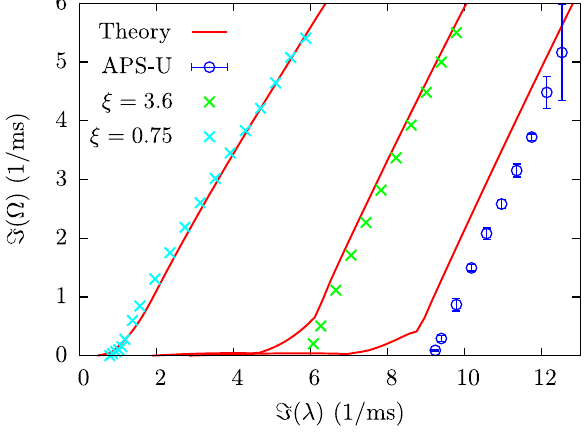
FIG. 9. Resistive wall growth rate as a function of ξ ¼ 0 rate λ for the APS-U. The theory subtracts off the transverse damping ≈ 0 . 065 1 = ms, while the tracking results include the rate 1 = τ y nonlinear tune shift with amplitude and chromaticity; the APS-U (blue dots) have the nominal chromaticity ξ ≈ 12 . 1 . The green and points show results for ξ k ξ σ z ξ 0 . 75 , respectively; the latter is nominally unstable to the y ¼ APS-U long-range resistive wall wakefield, whose growth rate ℑ ð λ Þ ≈ 0 . 88 1 =